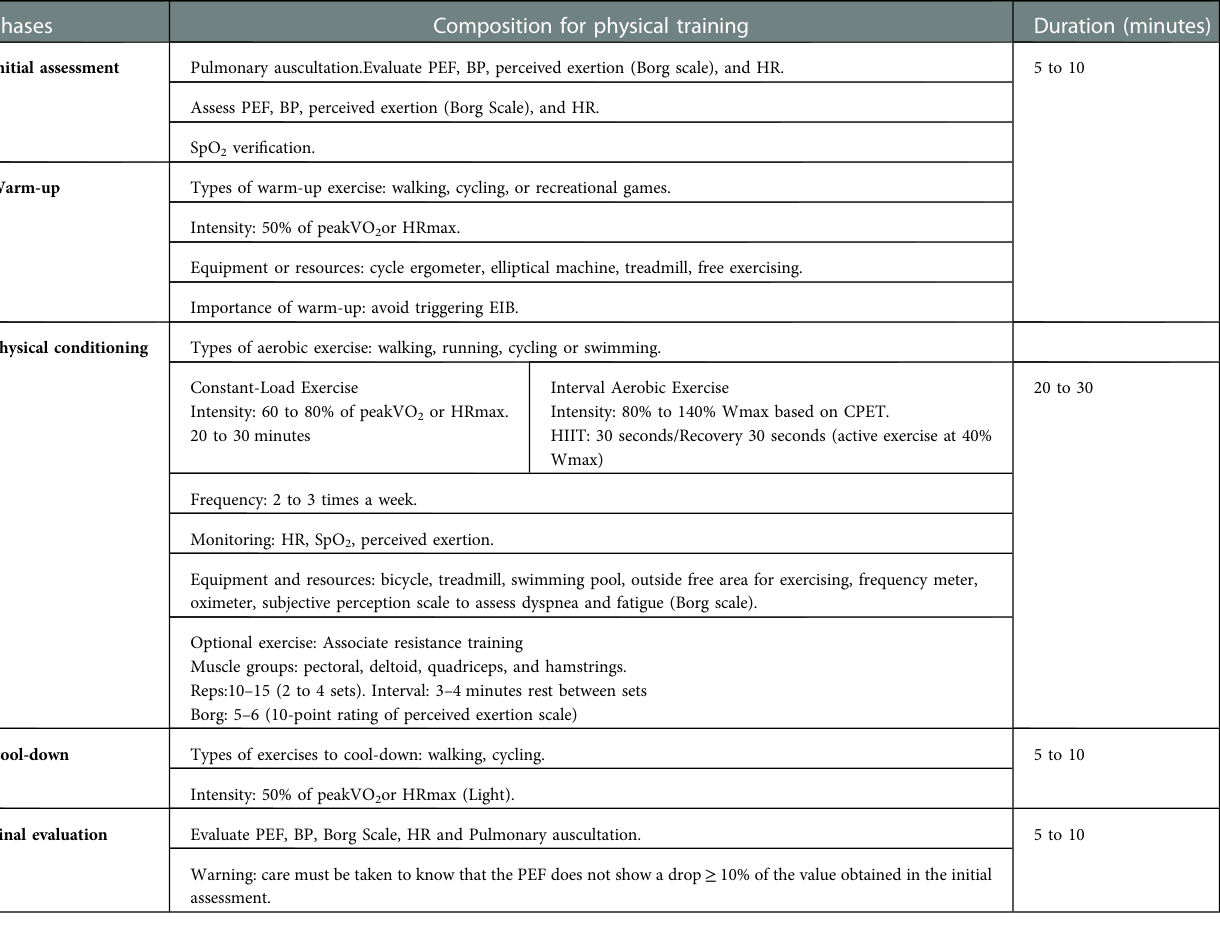
Table 1 Proposed Aerobic Training Protocol for patients with asthma. Phases Initial